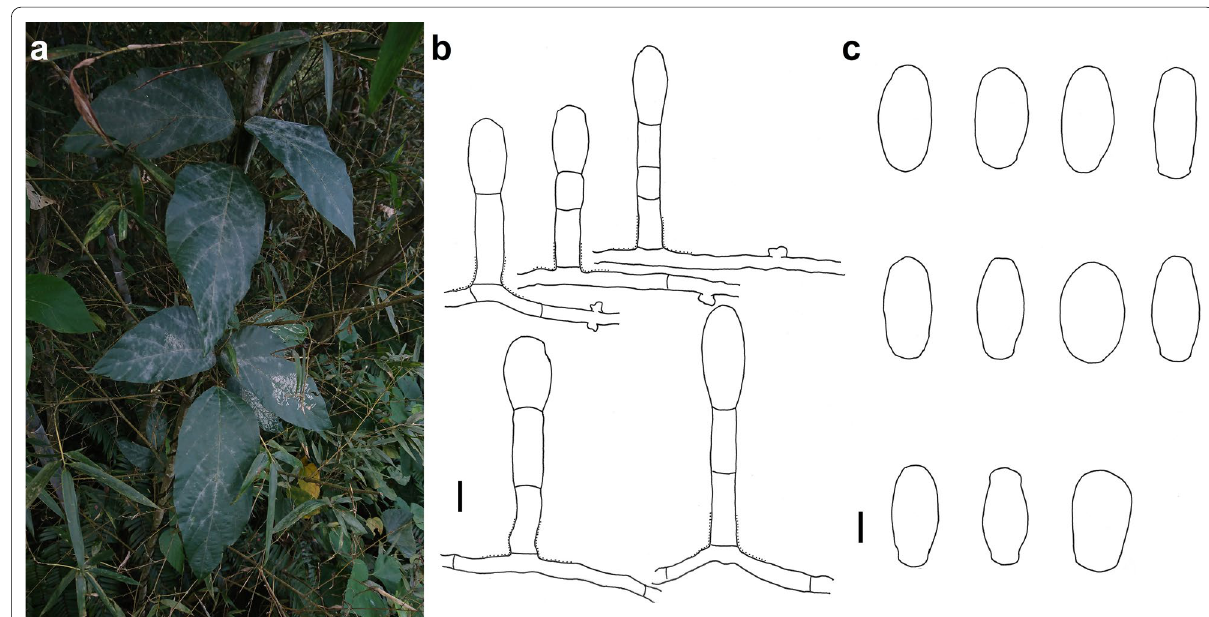
Fig. 3 Erysiphe glycines on Pueraria lobata (R. Kirschner 4638). a Powdery mildew symptoms on leaves. b Hyphae with appressoria and conidiophores with curved foot cell. c Conidia. Scale bars